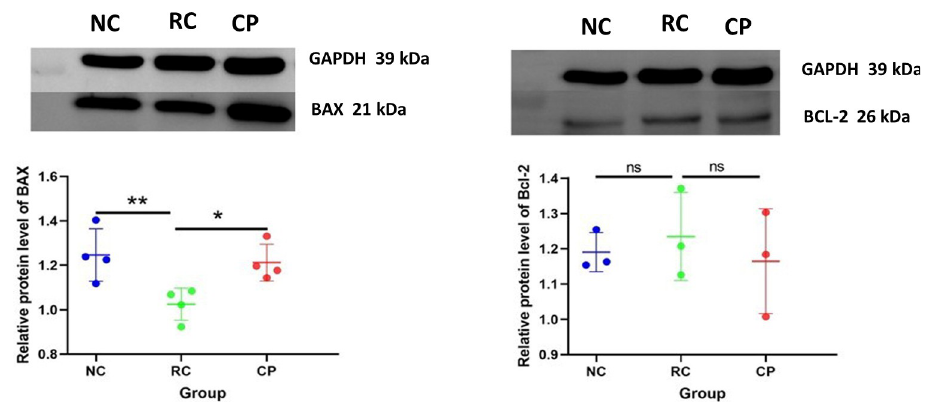
Fig 6. Western blot of BAX and Bcl-2 in tumor tissue. The expression of BAX (Molecular weight is 21 kDa), Bcl-2 (Molecular weight is 26 kDa), and GAPDH (Molecular weight is 39kDa) was measured using western blot. GAPDH was used as the loading control. Data are indicative of three separate experiments, and were analyzed using one way analysis of variance (ANOVA), � p < 0 . 05 , �� p < 0 . 01 , ��� p < 0 . 001 .